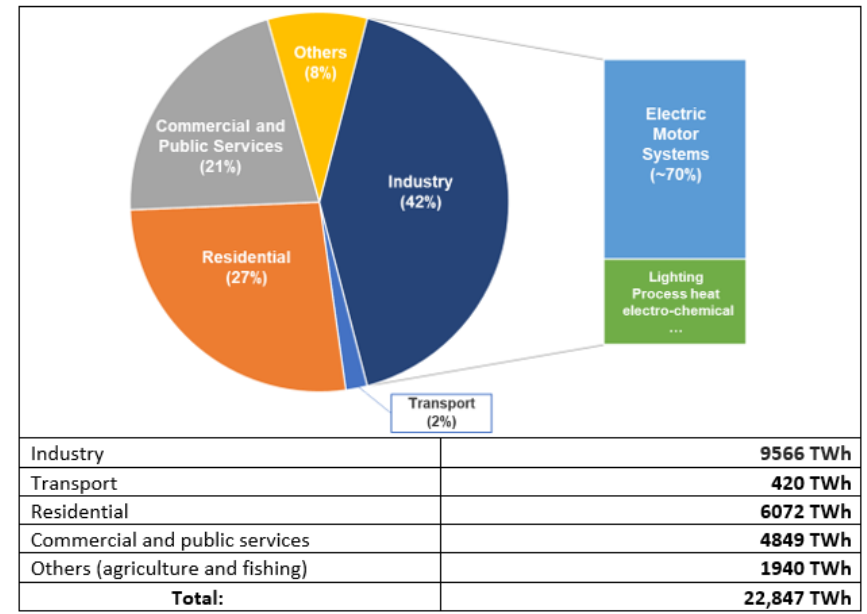
Figure 1. Worldwide electricity use / Industrial motor systems electricity use (Source: Authors, data from IEA, 2019).